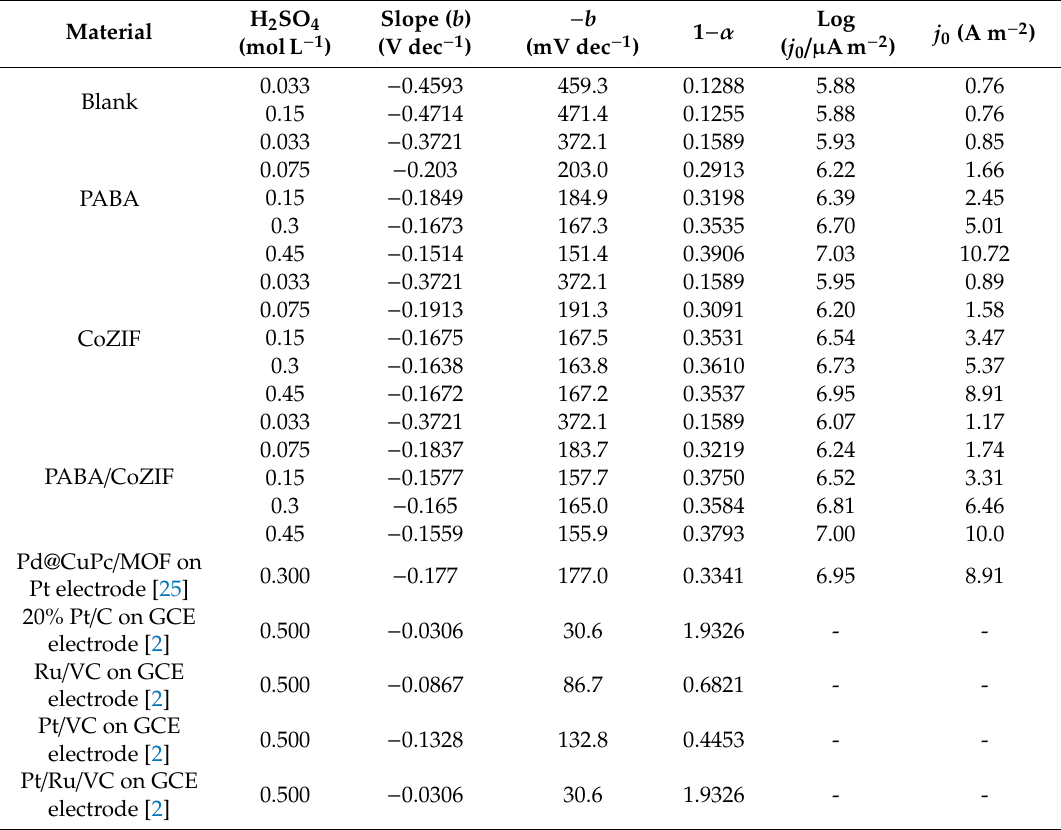
Table 1. Hydrogen evolution reaction (HER) parameters for the PABA, CoZIF and PABA / CoZIF